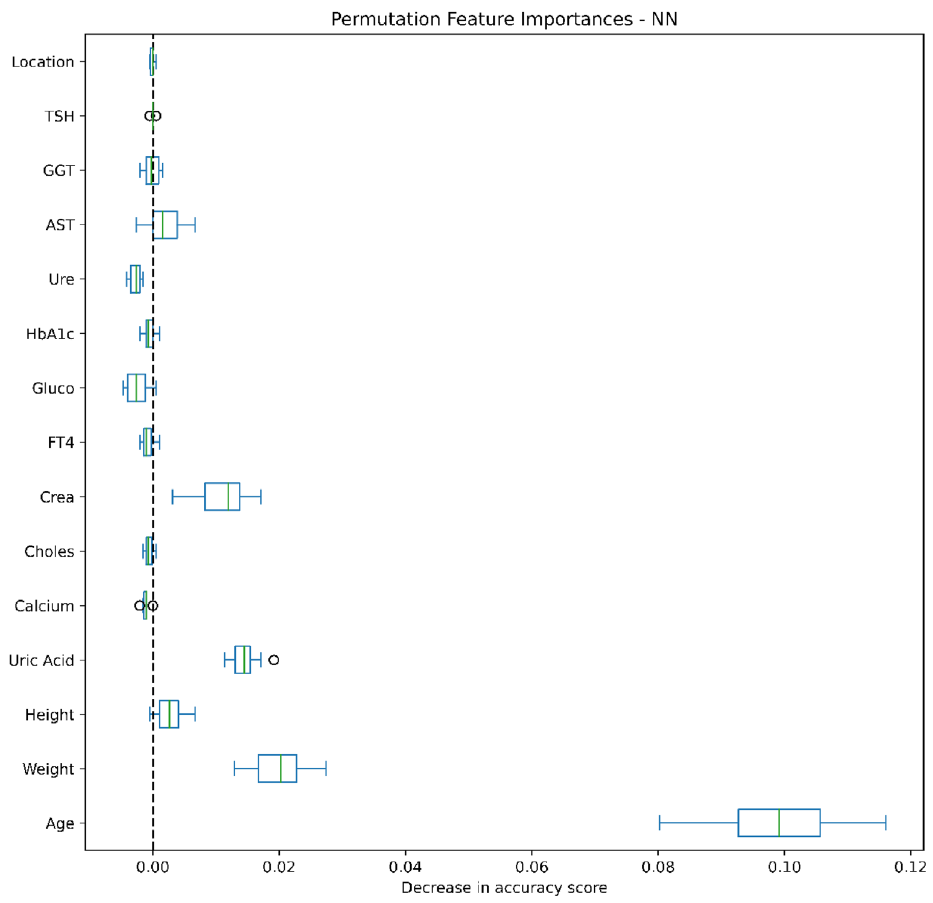
Figure 10. Feature importance for NN in the first